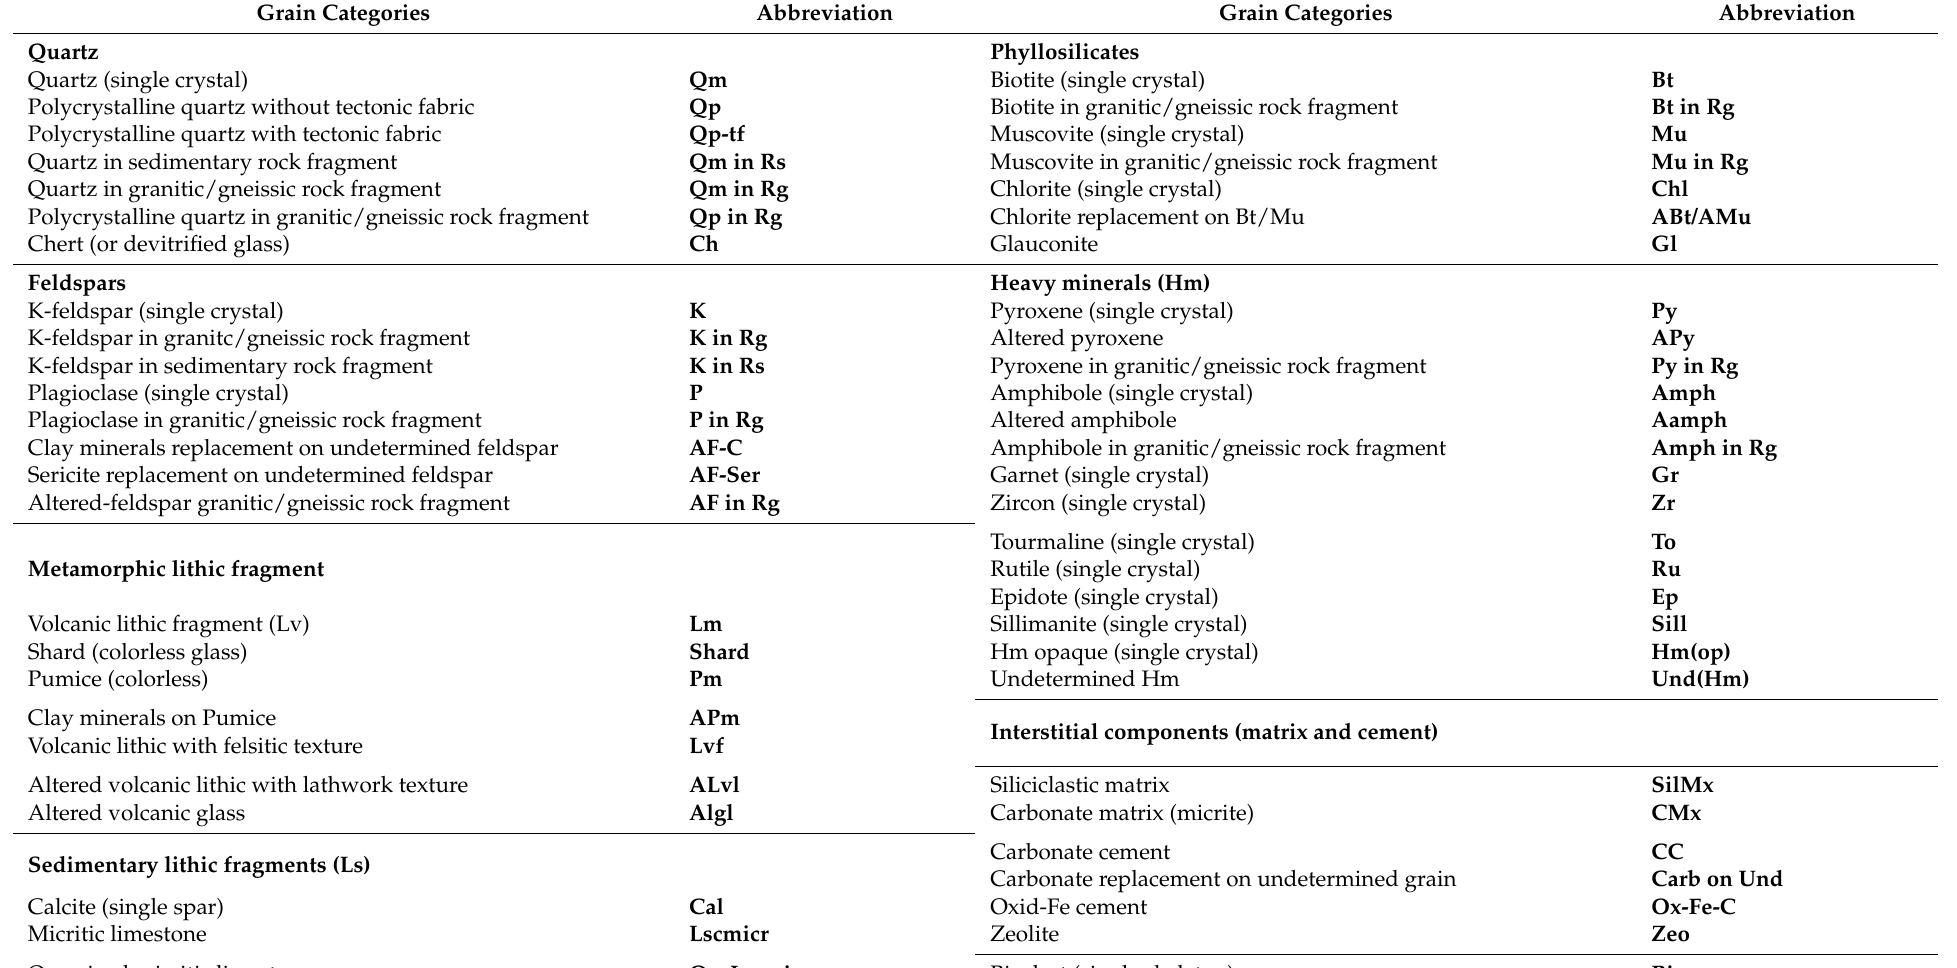
Table 1. Key to counted parameters (modified from